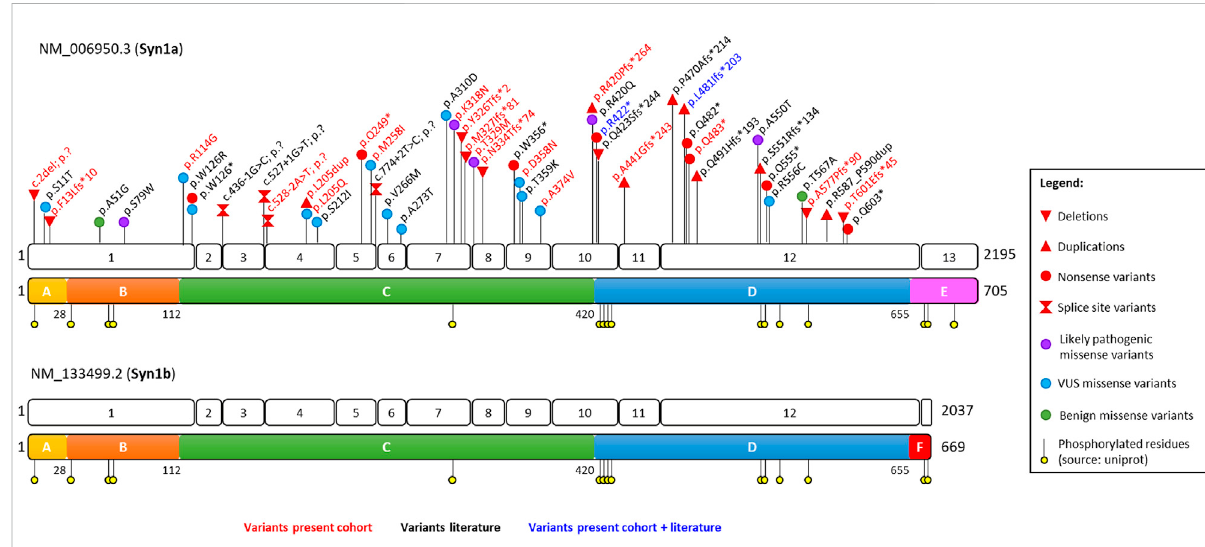
FIGURE 1 Schematic representation of the SYN1 gene and SYN1 protein with positions of the identi fi ed variants relative to exon and domains distribution. Variants identi fi ed in the present cohort are depicted in red, those reported in the literature in black, and those reported both in the literature and in ourcohortinblue.TheconservedA(N-terminalhighlyphosphorylateddomain),B(linker),andC(functionaldomain)domainsaredepictedinyellow, orange, and green, respectively; the variable D, E, and F domains in blue, pink, and red. Classi fi cation of the variants was performed based on ACMG criteria. Missense substitutions are subdivided in likely pathogenic, VUS, and benign based on the presence of functional data and their frequency in the healthy